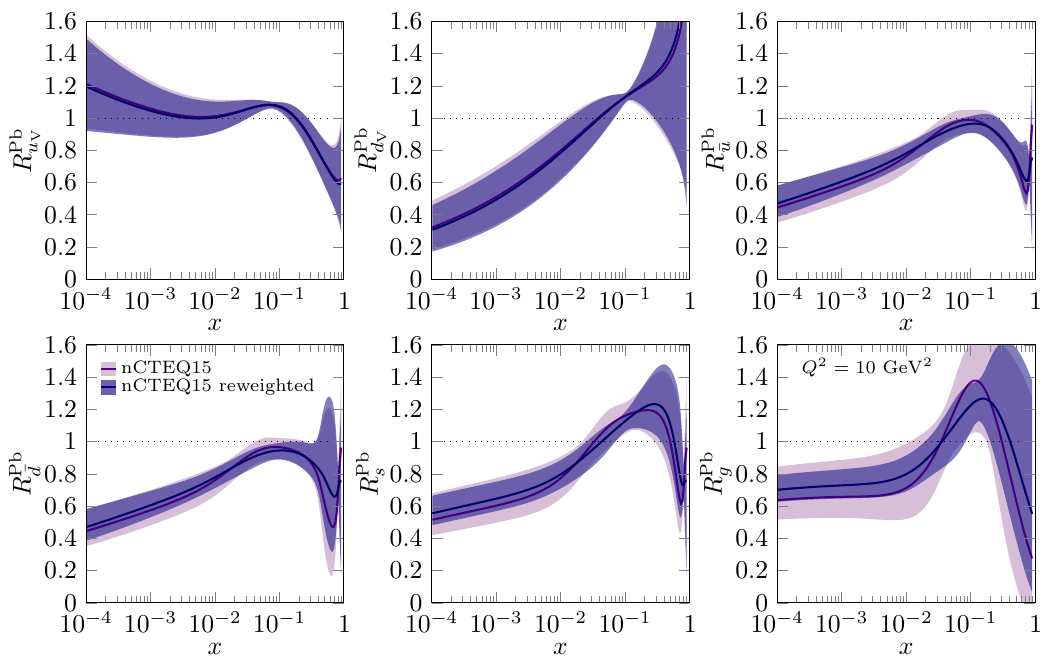
Figure 11 . The nCTEQ15 nuclear modi(cid:12)cations for bound-proton PDFs in Pb nucleus before (purple) and after (blue) reweighting with the LHCb data. The scale is Q 2 = 10 GeV 2